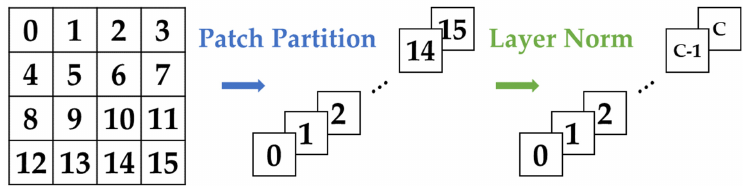
Figure 6. Example of patch partition module’s processing of input images.